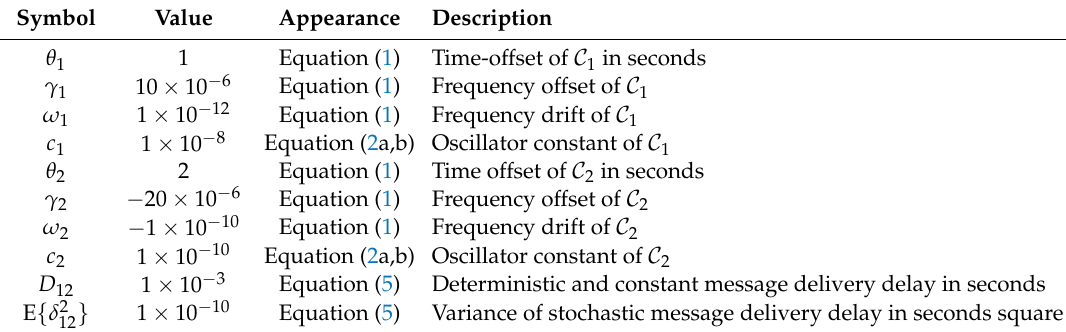
Table 3. Time record simulation